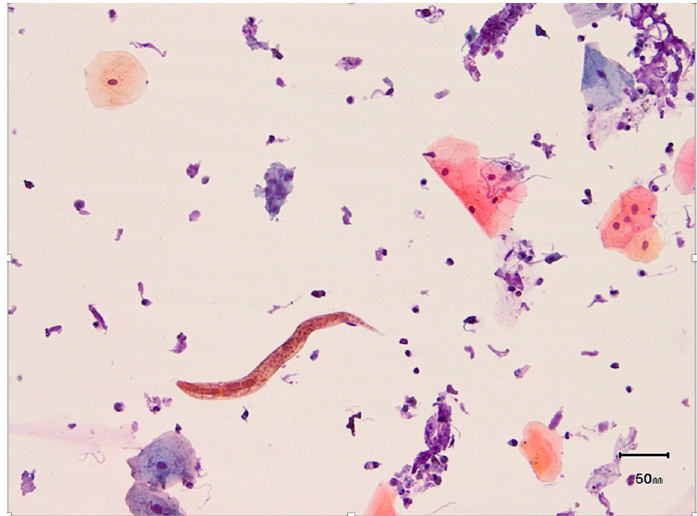
Figure 6. Case 2: Cytologic exam of sputum showing S. stercoralis .